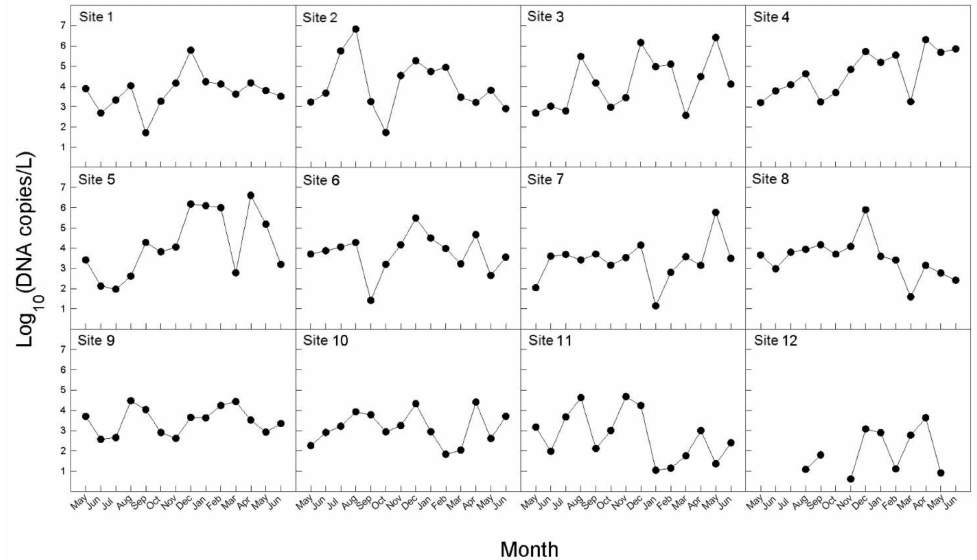
Figure 5. Monthly variations in eDNA concentration (copies/L) of seawater samples for B. californica from 12 survey sites from May 2017 to June